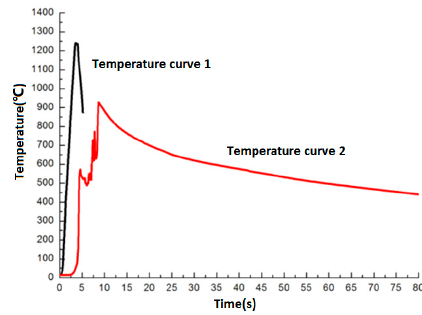
Figure 8. Temperature curves measured in the welding process.